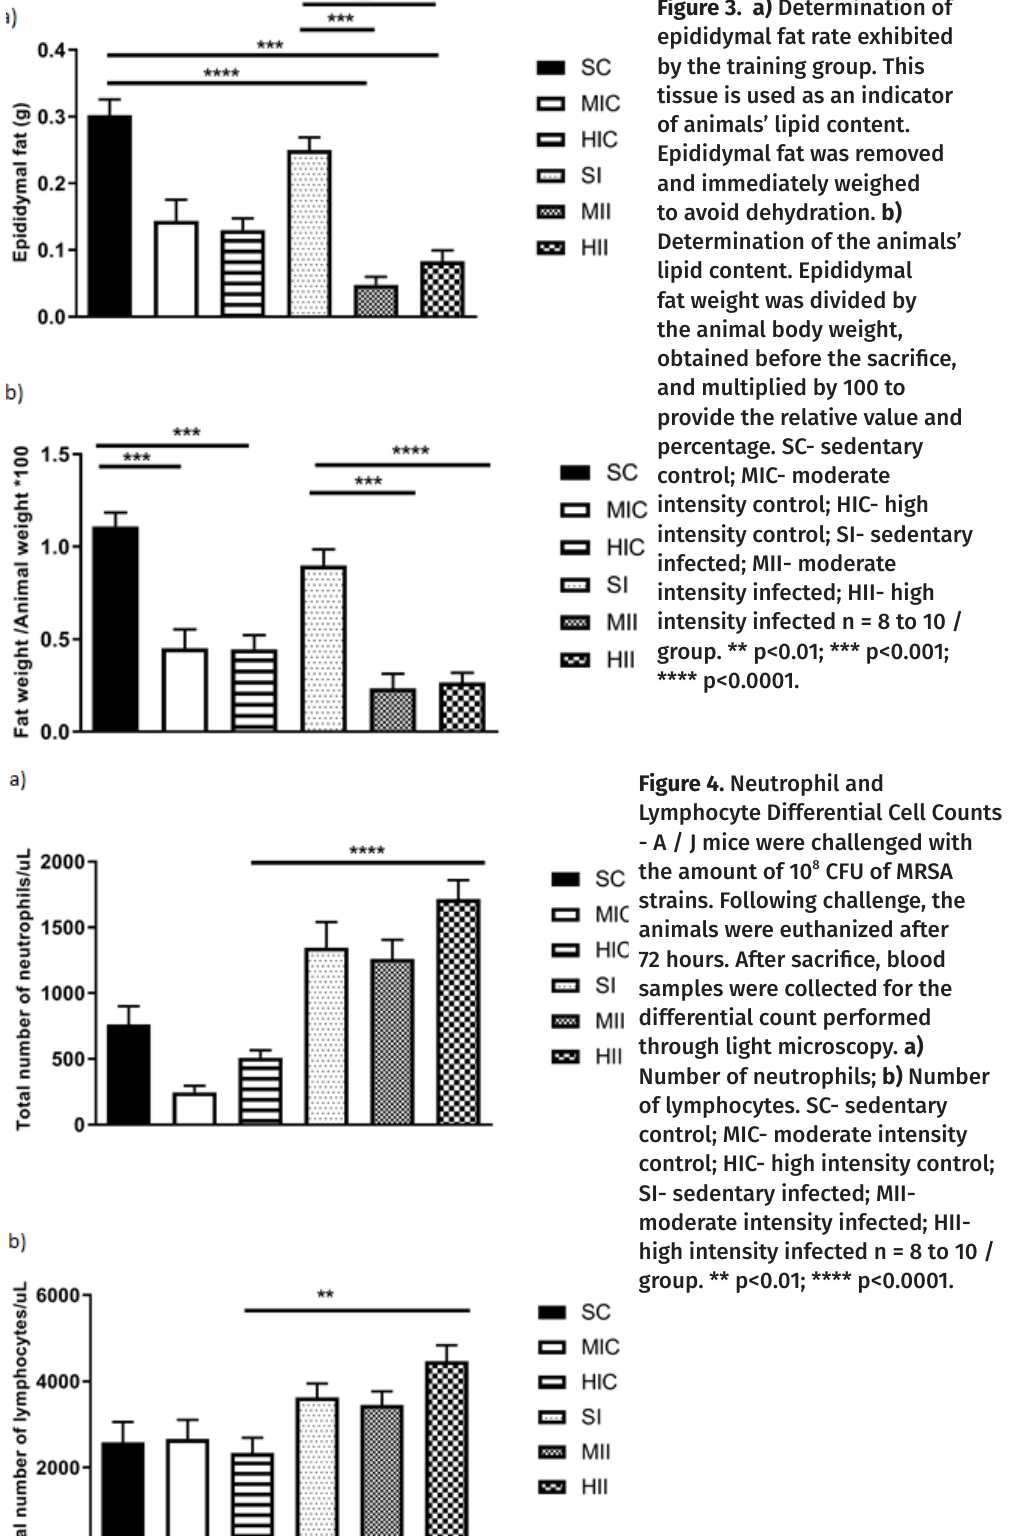
Figure 4. Neutrophil